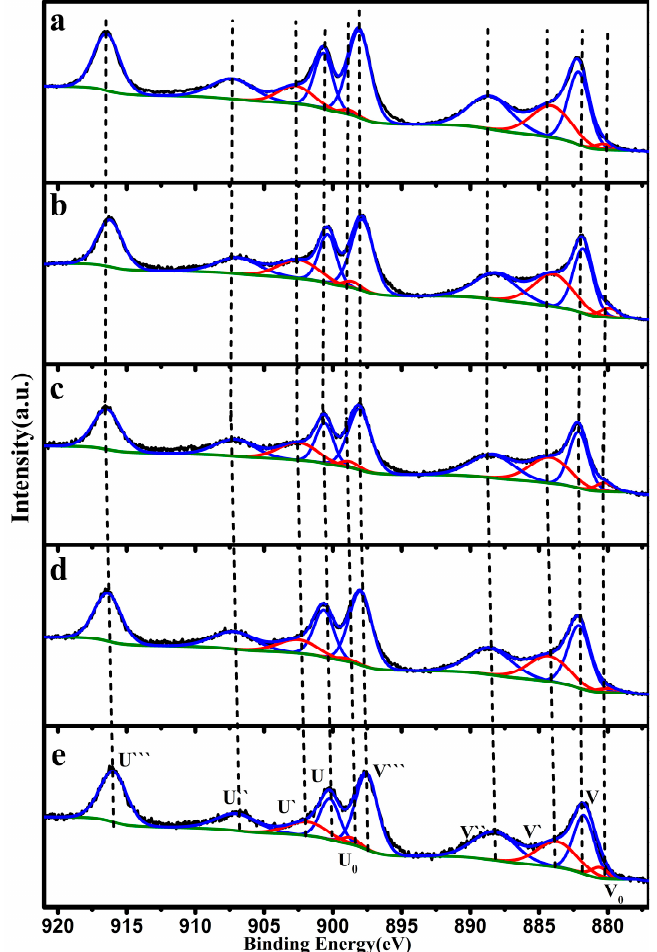
Figure 4. Ce 3d spectra of various CeO 2 nanomaterials ( a ) 2MCeO 2 np, ( b ) 6MCeO 2 nr, ( c ) 12MCeO 2 nr, ( d ) 6MCeO 2 nc, and ( e ) 12MCeO 2 nc. Table 2. XPS, Raman characterizations, and catalytic performance of various CeO 2